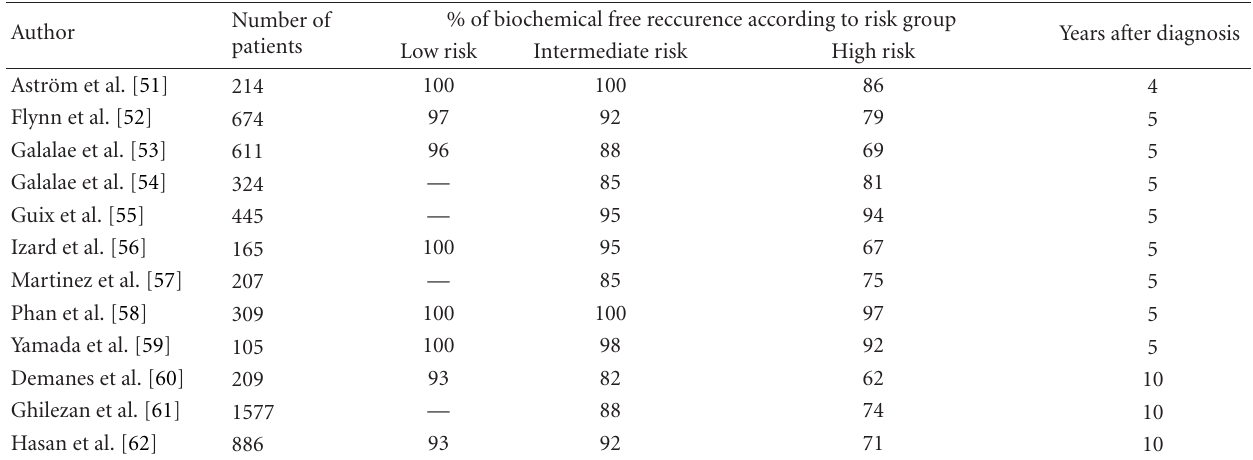
Table 4: HDR brachytherapy: percentages biochemical free relapse after combined with external-beam radiation therapy according to risk group for prostate cancer